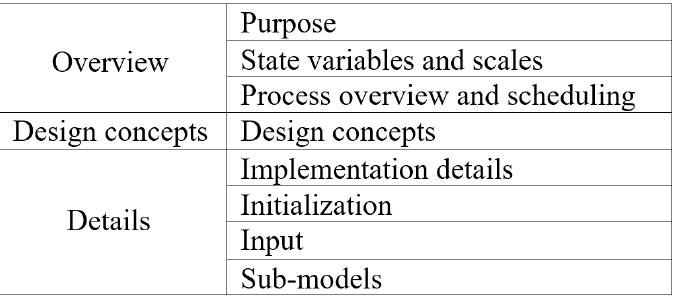
Figure 1. ODD Design protocol [12].